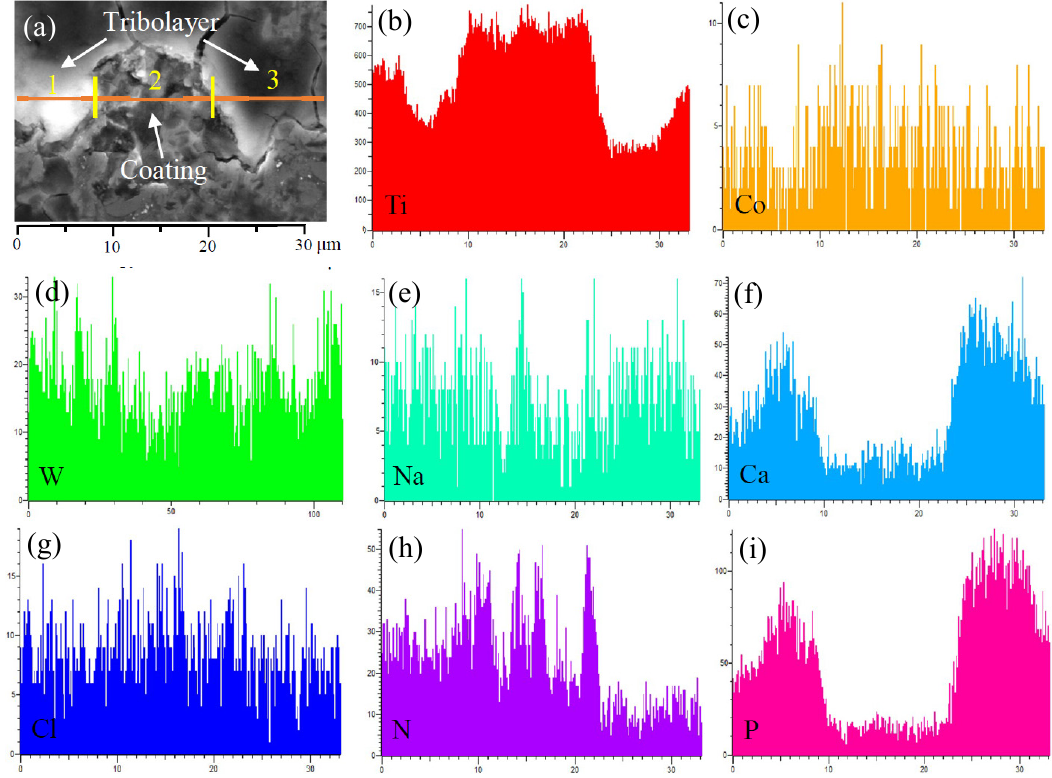
Figure 13. EDS line scanning results of the tribolayer. ( a ) EDS line; ( b )Ti; ( c )Co; ( d ) W; ( e )Na; ( f ) Ca; ( g ) Cl; ( h )N; ( i ) P.